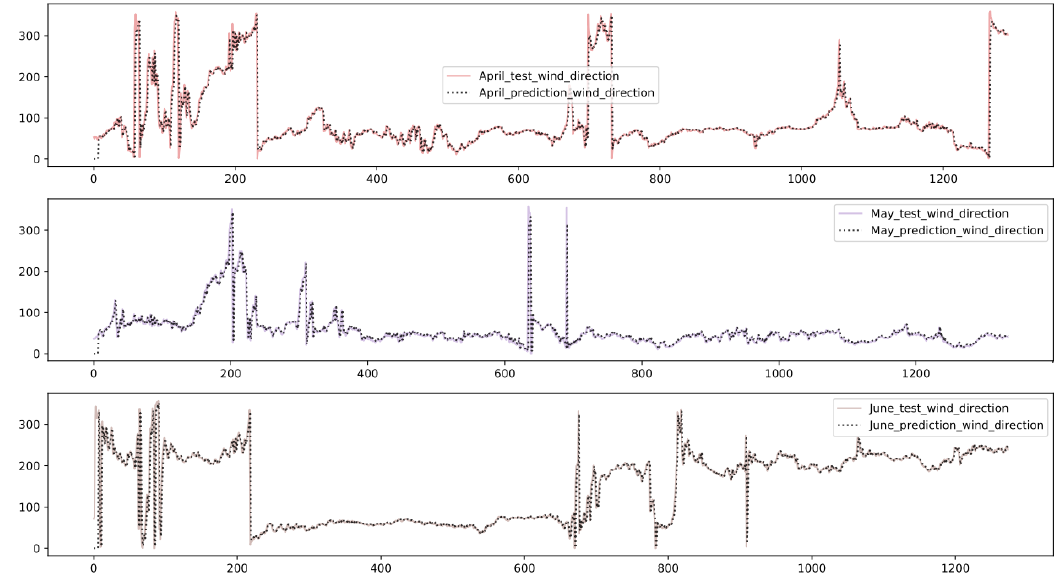
Figure 16. The wind direction predictions for the test set of April, May, and June.